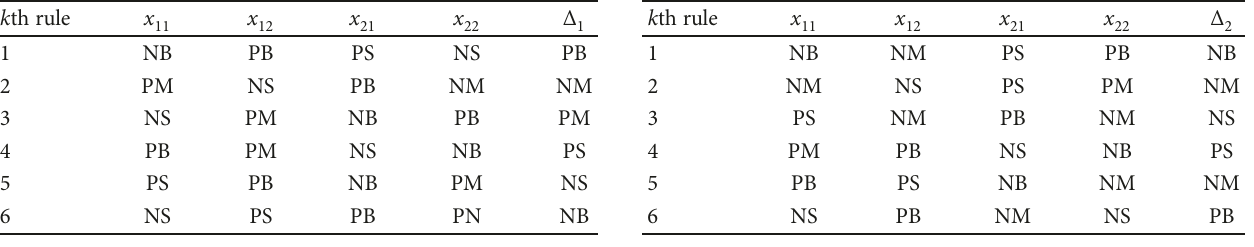
X . Table 2: Fuzzy rules of the FLS F 1